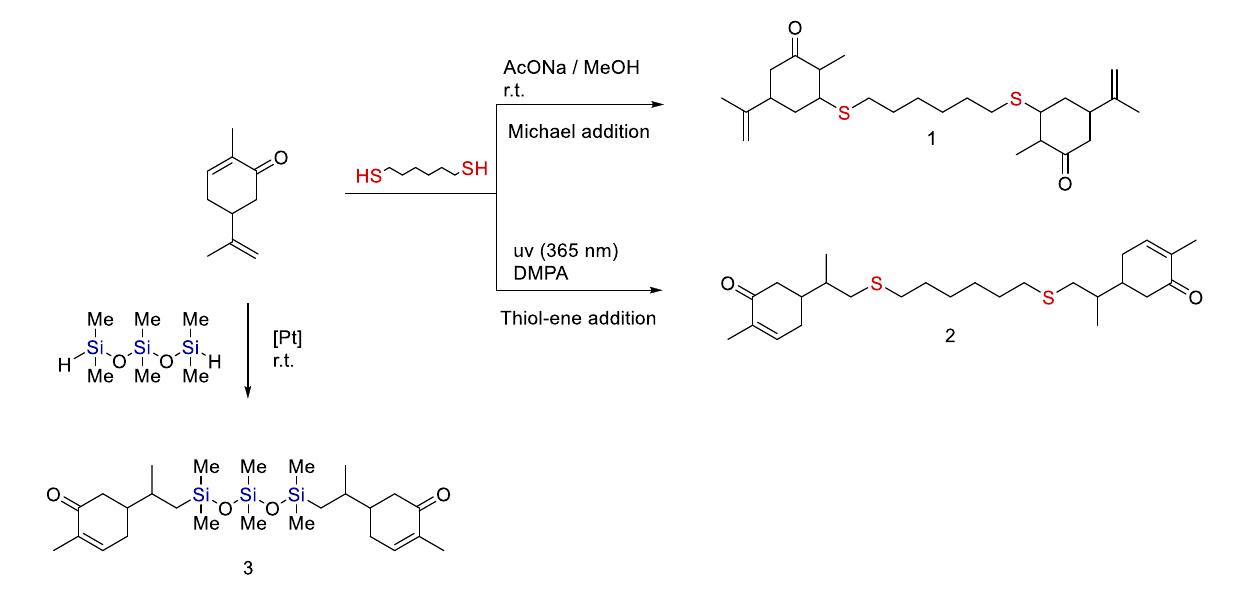
Figure 30. Strategies for the synthesis of functional derivatives of carvone by hydrosilylation and hydrothiolation. Adopted from Ref. [129].